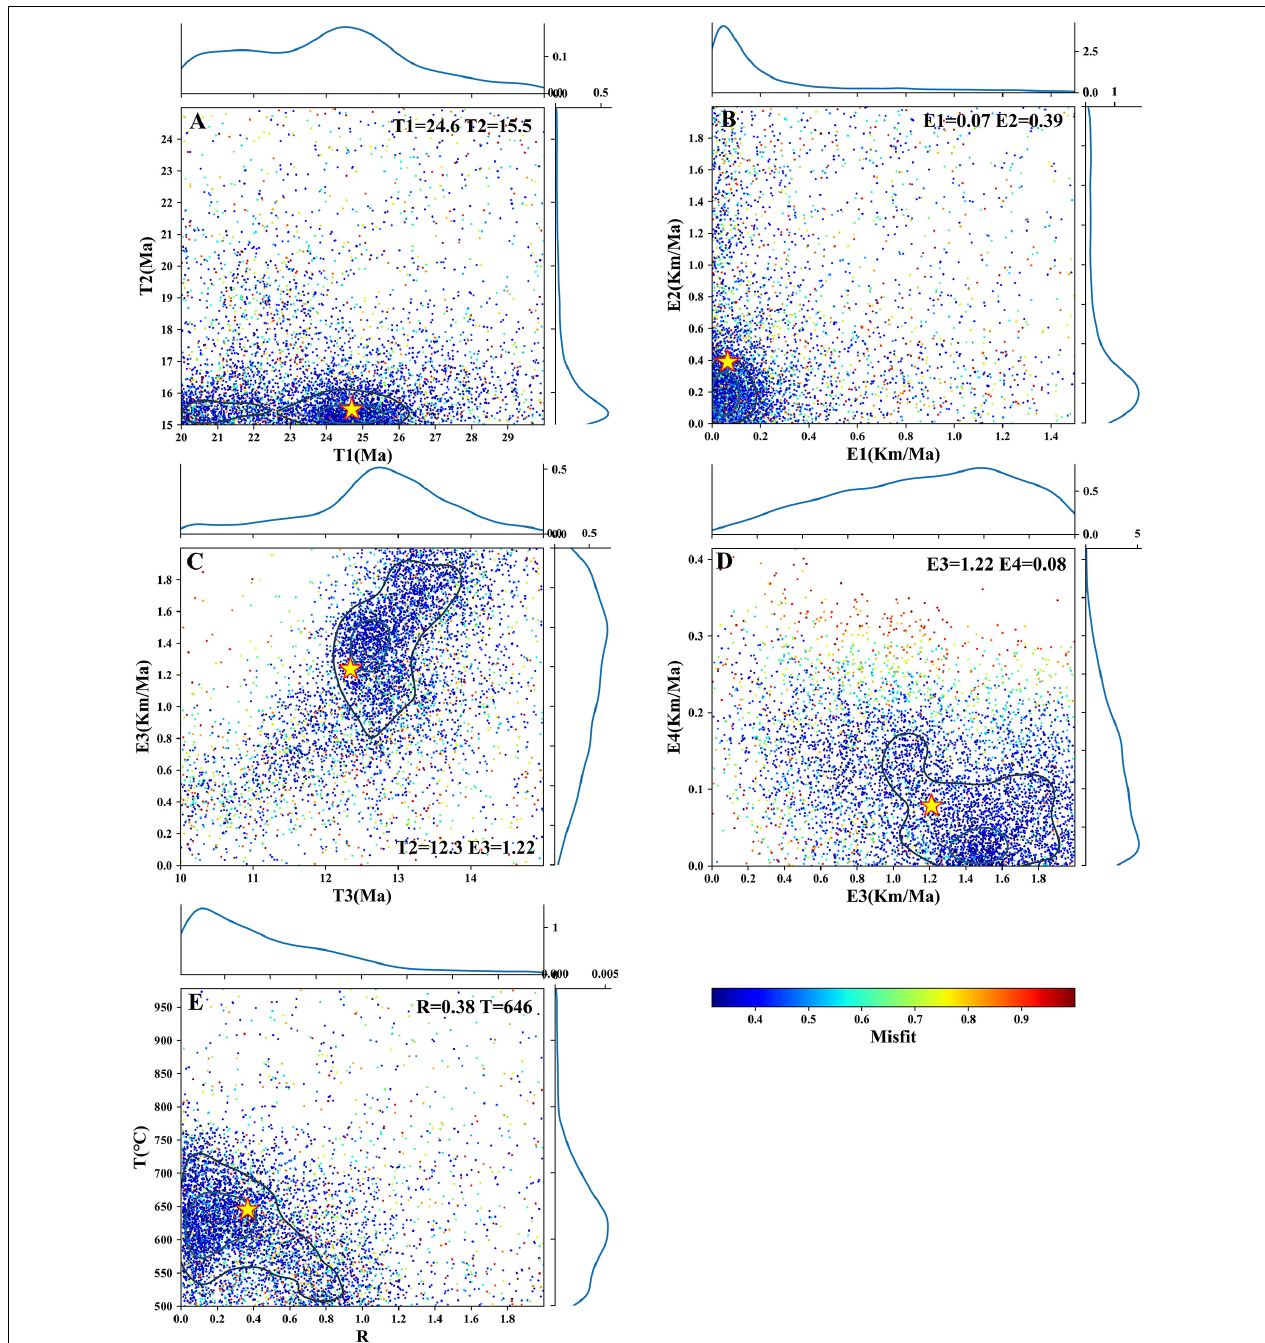
FIGURE 4 | Scatterplots of Pecube inversion misfits for the four-stage denudation scenario model of the Lhasa River drainage. Colored dots represent individual forward-model runs plotted in 2D projections of the parameter space with color corresponding to misfit values. Posterior probability density functions for parameter values are plotted along the axes. The best-fit solution is represented by a yellow star with 2 σ (black) and 1 σ (light blue) confidence contours. (A–D) Transition time and denudation rate during the four stage (transition time T1, T2, and T3; denudation rate E1, E2, E3, and E4); (E) basal temperature T and relief factor of initial topography R